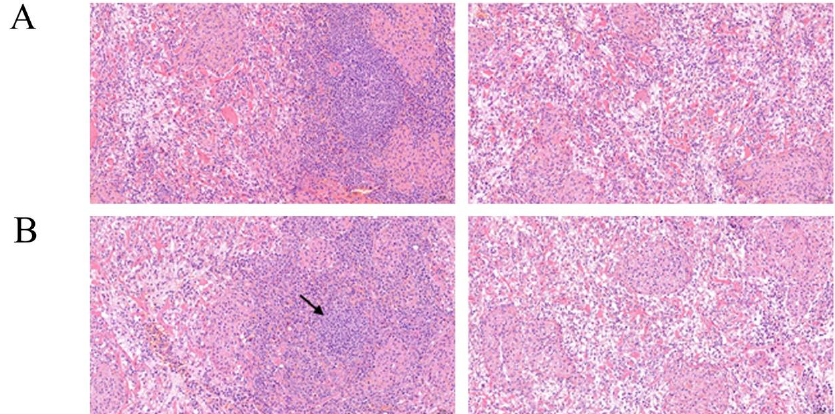
Figure 1. Histological structure of the spleens stained by hematoxylin and eosin ( × 20) ( n = 3/group): ( A ) control group; ( B ) ammonia group. The histopathological lesions included the volume of splenic nodules decreased. Lymphocyte count (black arrow) was reduced.